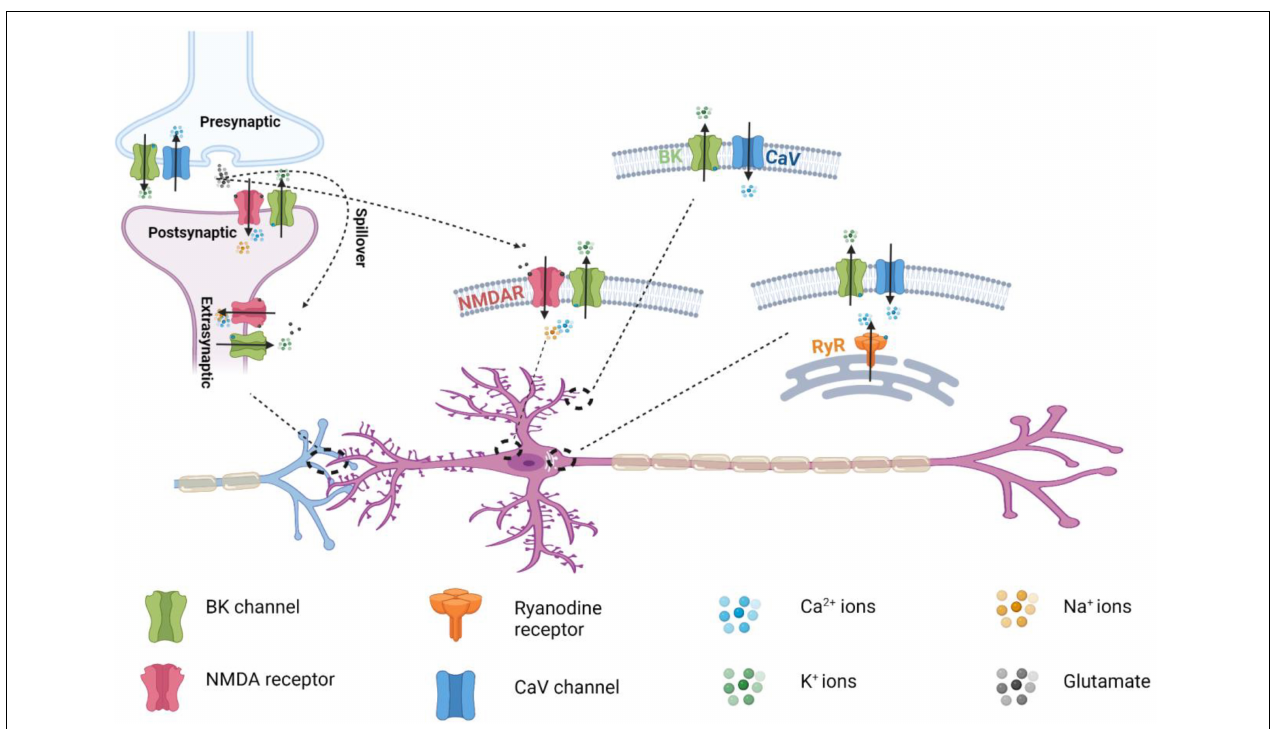
FIGURE 5 | Distribution of the nanodomain coupling of BK channels with different Ca 2 + permeable channels in